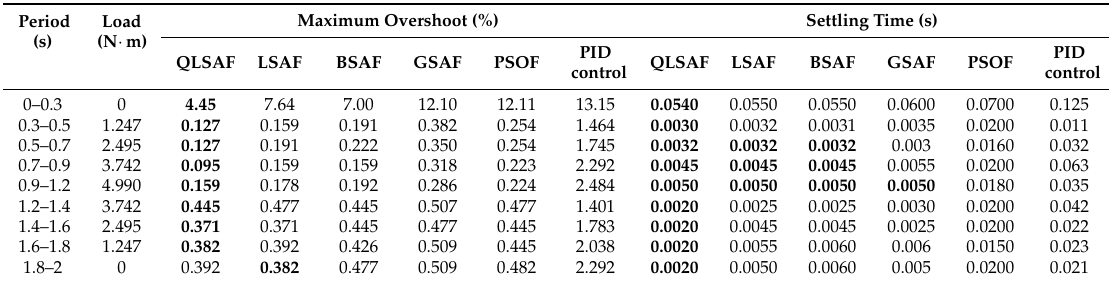
Figure 21. Stator currents with change in the mechanical load. Table 12. Detailed speed response to changes in mechanical load